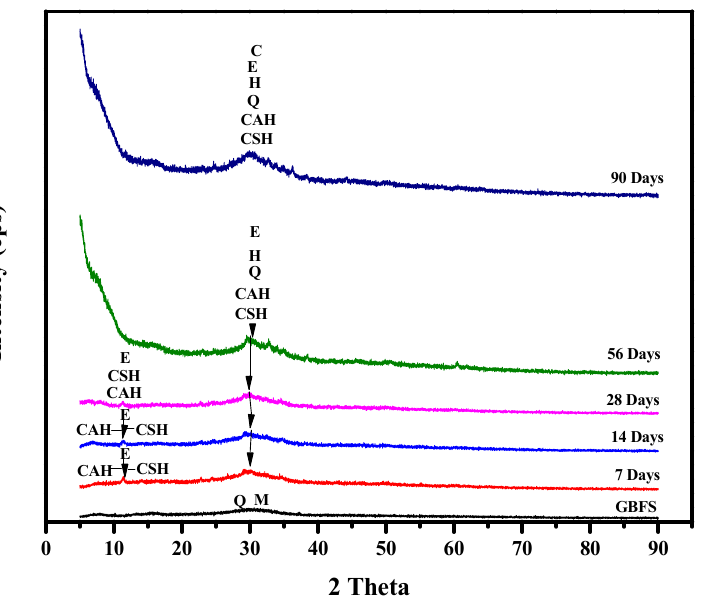
Figure 6. XRD pattern of samples (M = magnetite, Q = quartz, H = hydrocalumite, CSH = calcium silicate hydrate, CAH = calcium aluminate hydrate, C = calcite, E = ettringite).